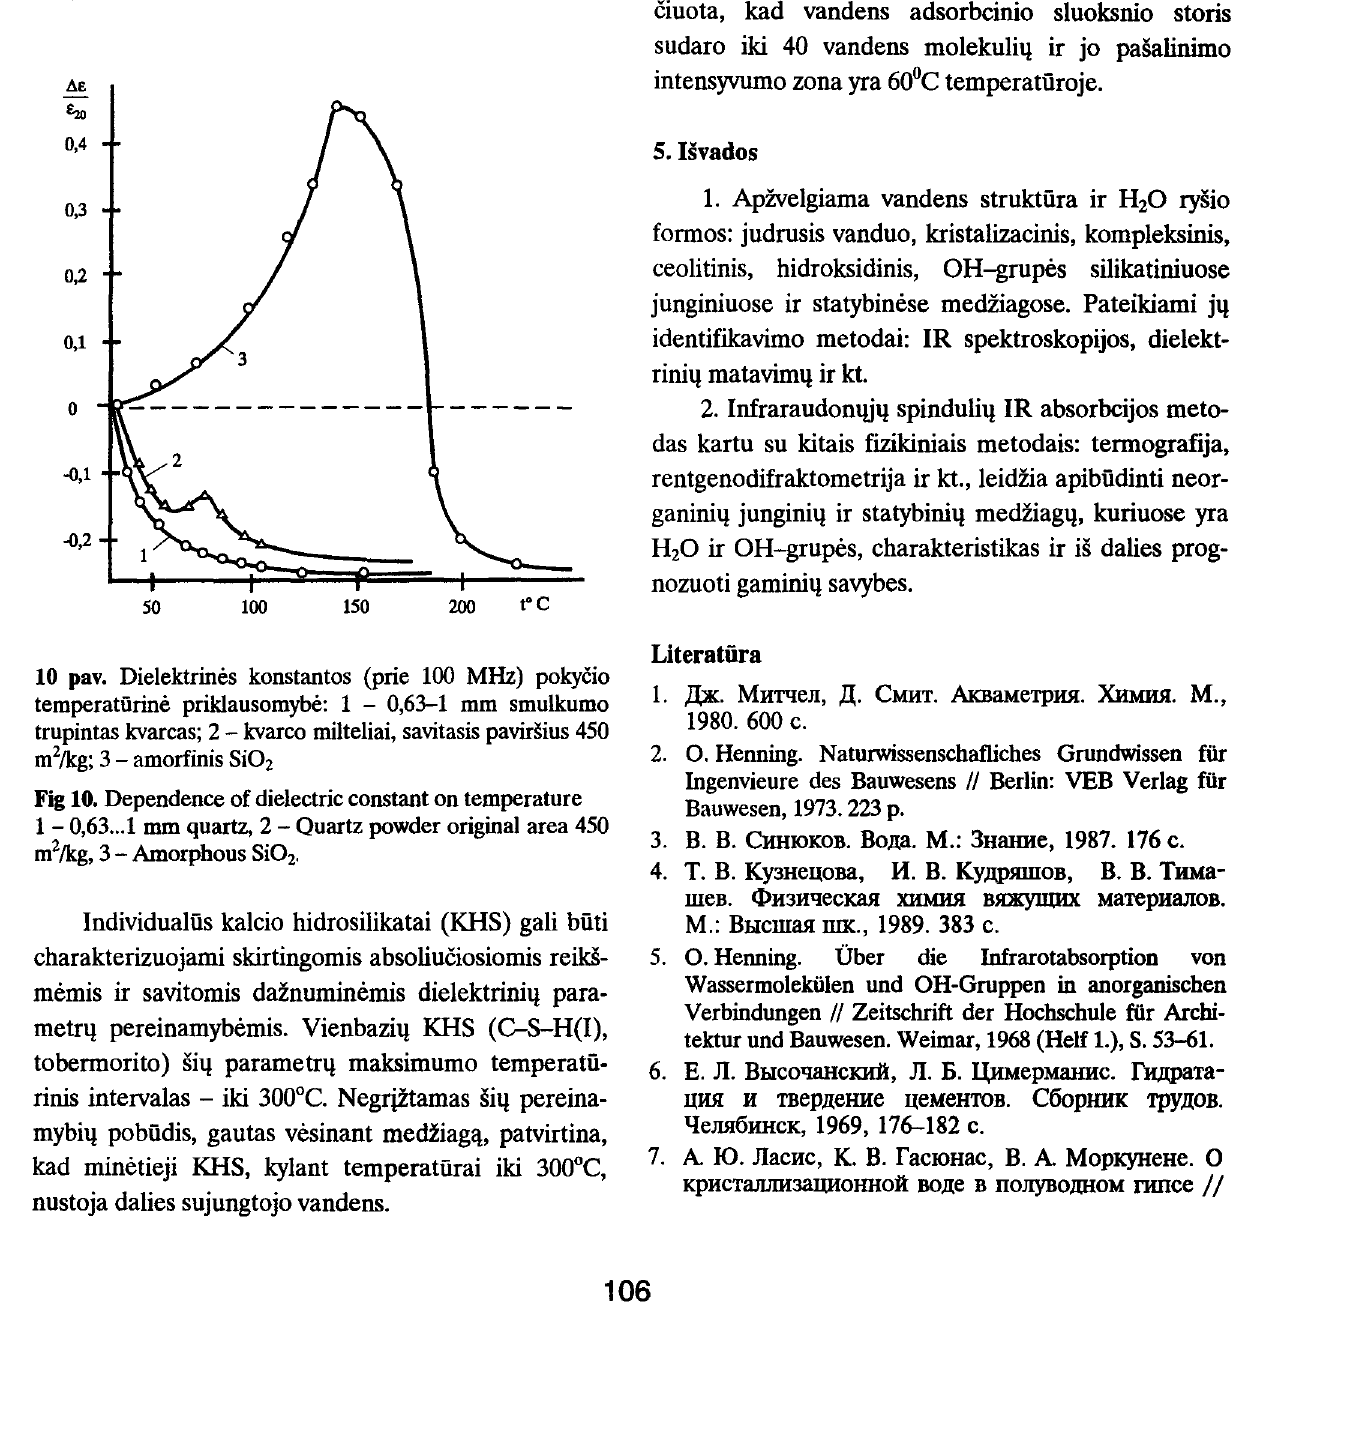
Fig 9. Dependence of the dielectric constant of water £ on